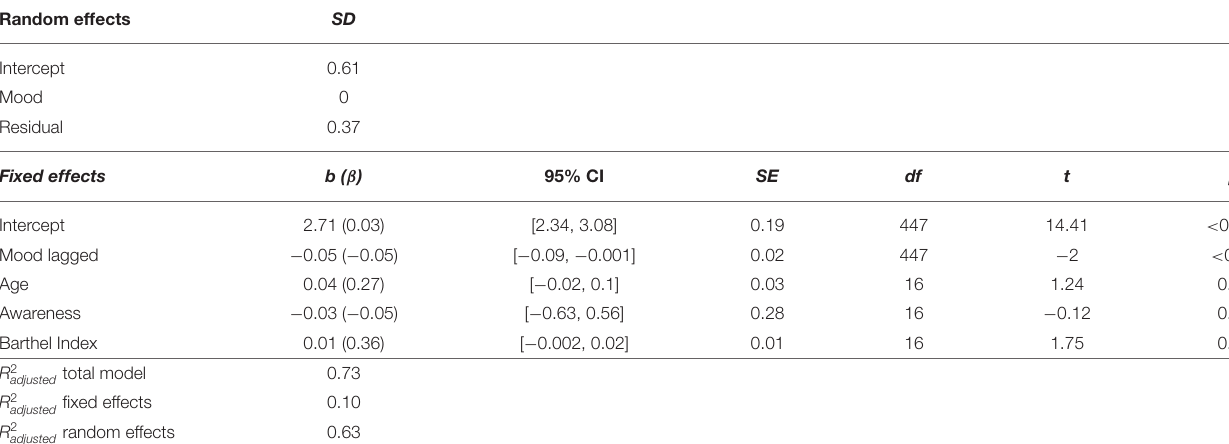
TABLE 2 | Random intercepts and slopes model with patients’ time-lagged mood (t-1) as the level 1 predictor, patients’ age, awareness of illness, and the Barthel Index as the level 2 predictor and patients’ self-reported functionality as dependent variable. Random effects